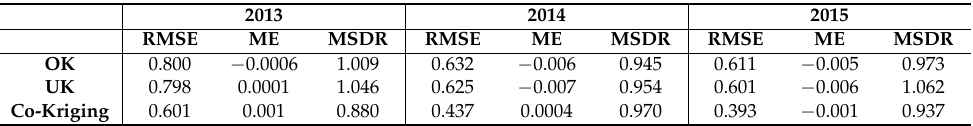
Table 5. The cross-validation results with the leave-one-out method of soil Fe predictions. The root mean square error (RMSE), mean error (ME), and mean squared deviation ratio (MSDR) are referring to ln(Fe), where Fe is in